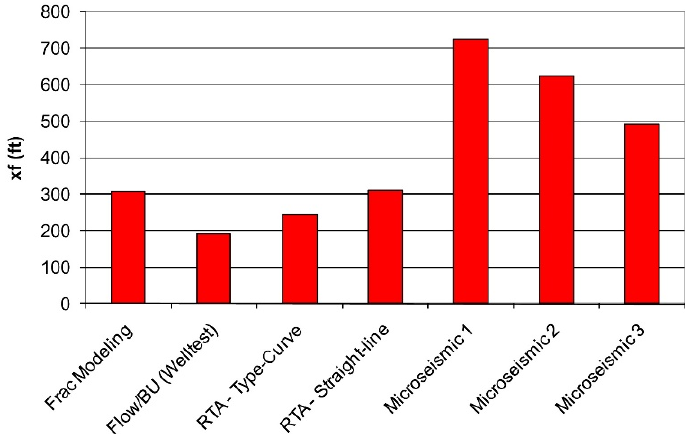
Figure 5. The hydraulic-fracture half-lengths ( x f ) derived from different methods. Reprinted with permission from Ref. [141]. Copyright 2012, Elsevier. The shape of the rock FPZ develops with the increase in the load, and generally, a strip shape is formed after reaching the peak load (Figure 6). The FPZ aspect ratio of Aue granite is 0.01–0.1 [144]. The experiment conducted by Zhang et al. [145] using sandstone shows that under peak load, the FPZ width is 0.4–0.5 times its length, and the FPZ width is significantly affected by the specimen thickness. The shape of the PFZ obtained via ex- periments is shown in Figure 7.